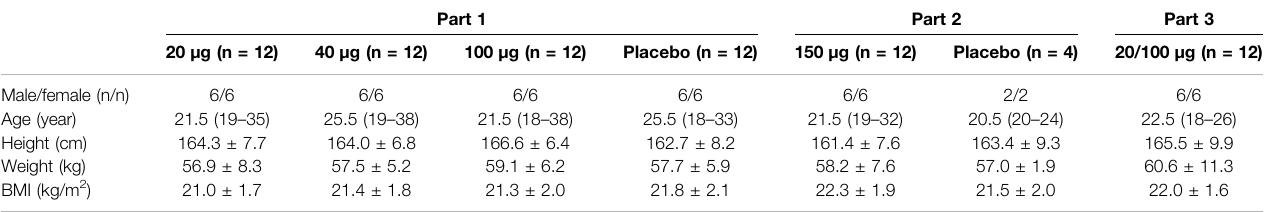
TABLE 1 | Demographic characteristics of the study